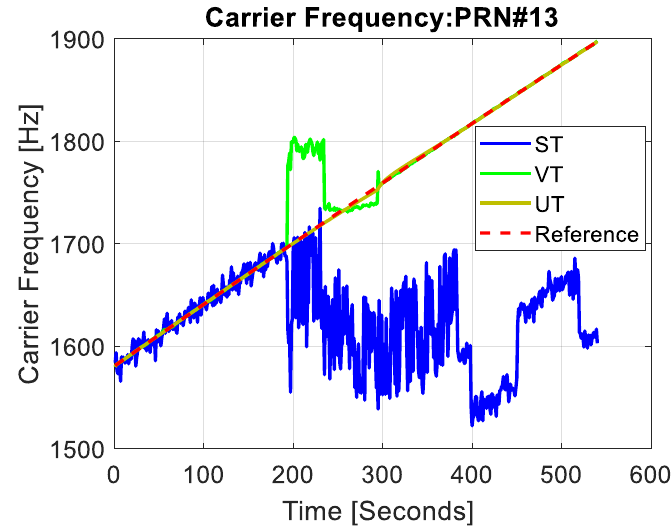
Figure 14. Carrier Frequency PRN13.